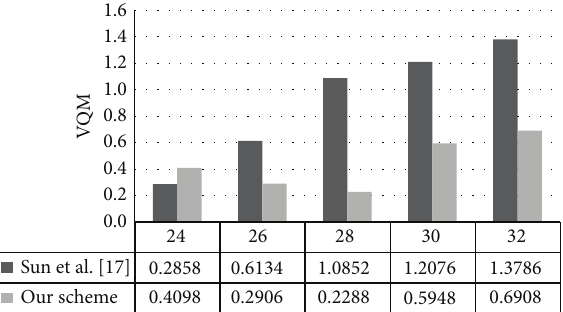
Figure 18: Comparison of imperceptibility